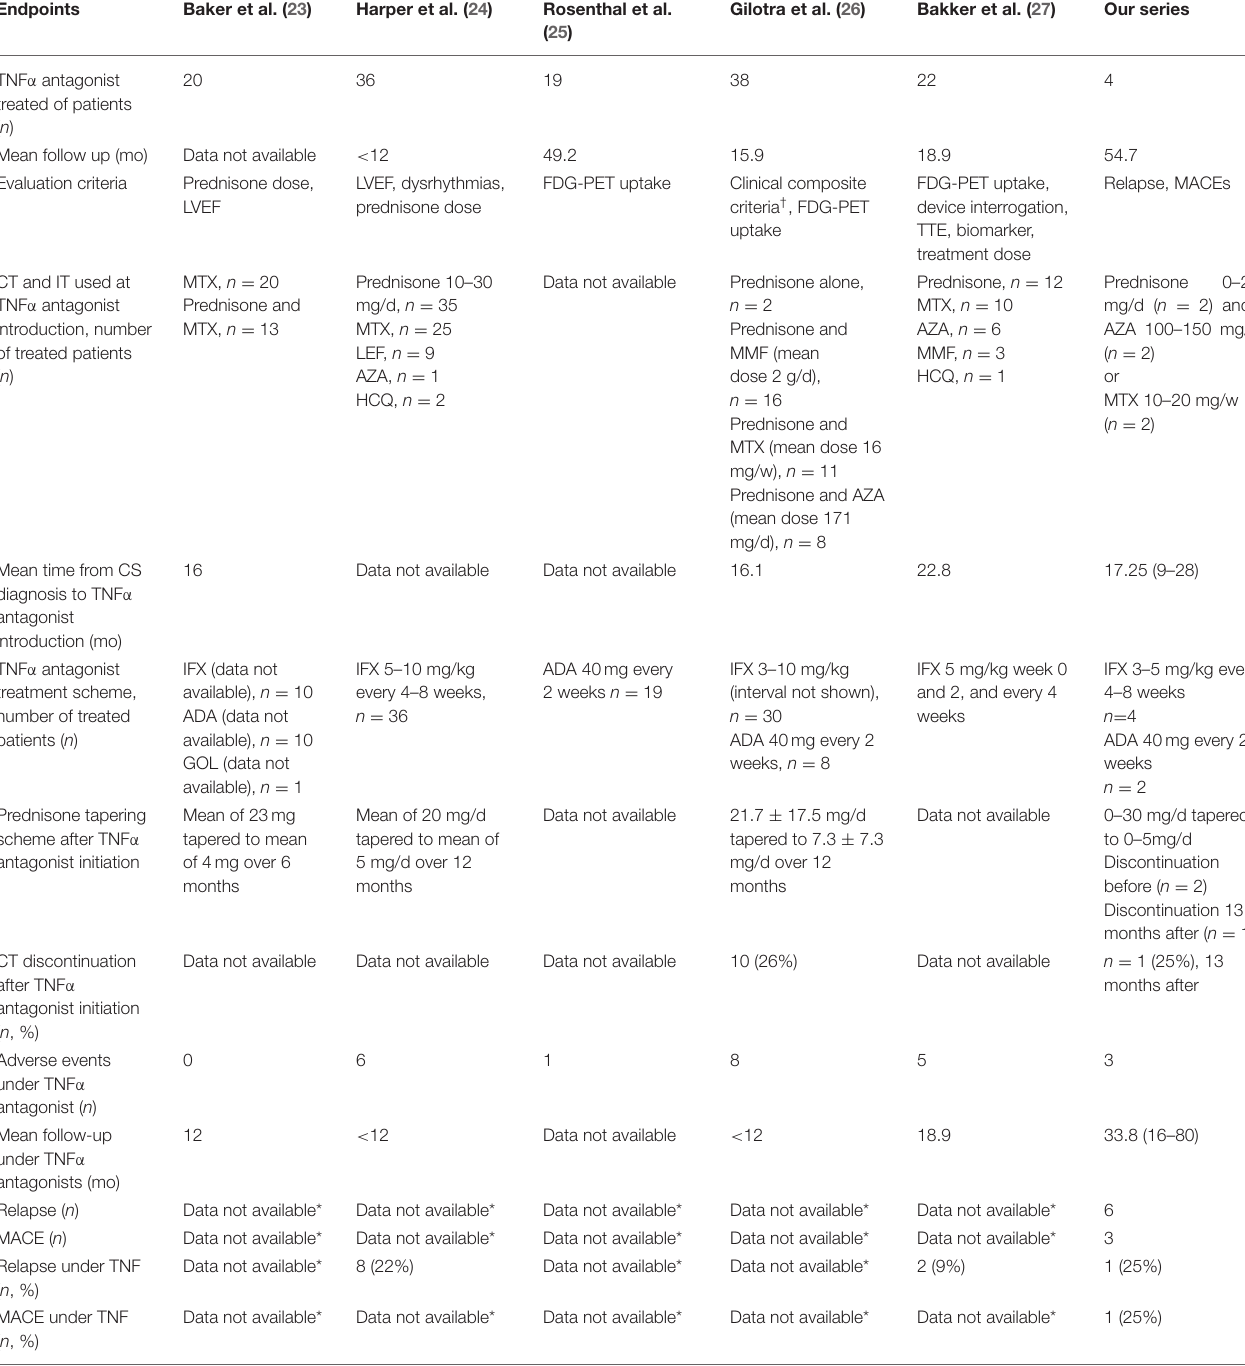
TABLE 3 | Outcomes in recent studies upon TNF α antagonists’ efficiency in